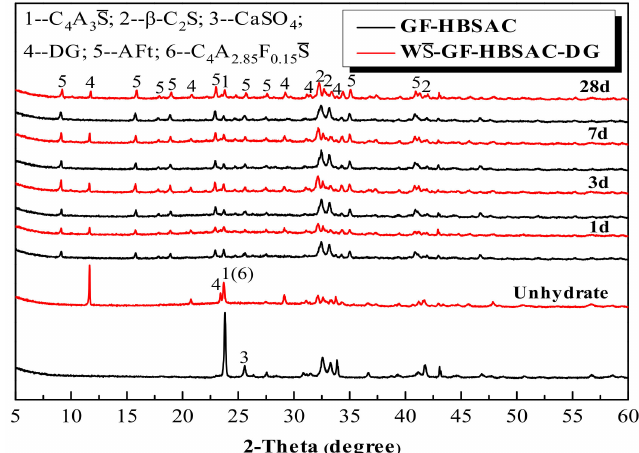
Figure 15. X-ray di ff raction (XRD) patterns of the Series GF-HBSAC-X cement hydration products at di ff erent curing ages.